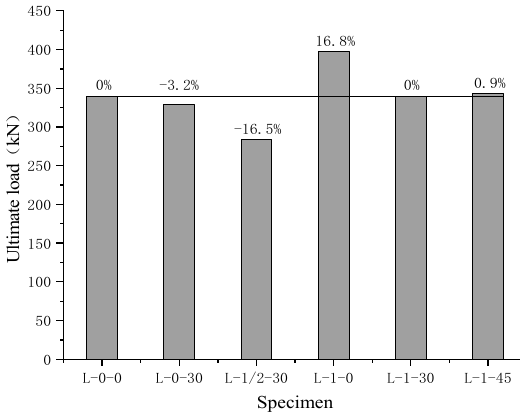
Figure 9. Comparison of the ultimate load of each specimen.